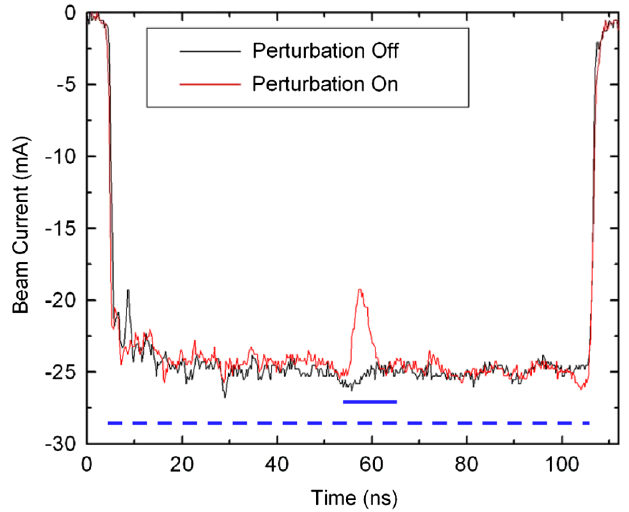
FIG. 2. (Color) Beam signal at the Bergoz showing the rectan- gular beam with a negative perturbation. The red/black traces show the beam current with perturbation on/off. The perturbation aptitude is roughly 25% of that of the main beam. The camera gates used were 10 ns (solid line) and 100 ns (dotted line).